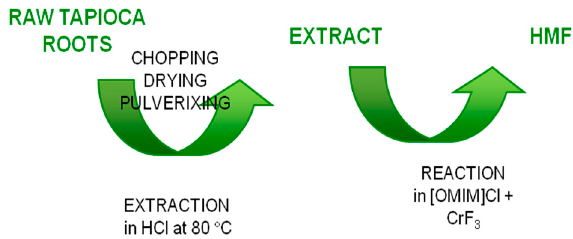
Figure 6. Scheme of the process from raw tapioca roots to HMF [38].